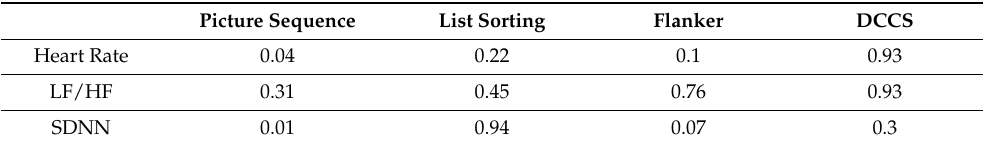
Table 5. Correlational analyses for heart rate variability quartile averages (heart rate, LF/HF, and SDNN) and all cognitive testing score quartile averages. Picture Sequence